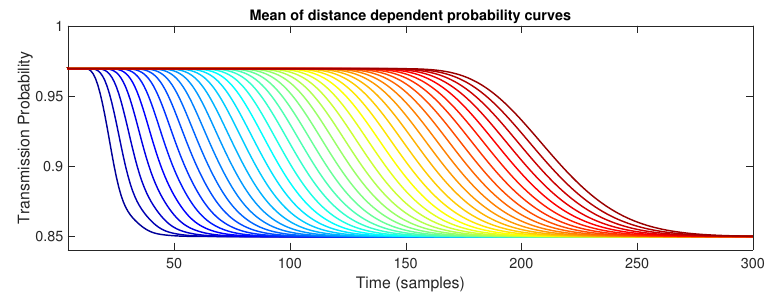
Figure 19. Monte Carlo simulation of 10,000 trials for the mean of the time evolution of the local successful probability transmission p i ( (cid:96) i ( k )) , which is dependent on the inter-vehicle distance.